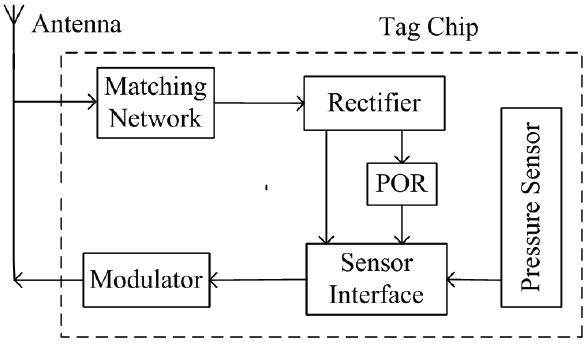
Figure 1. Block diagram of the proposed passive wireless pressure sensor tag.